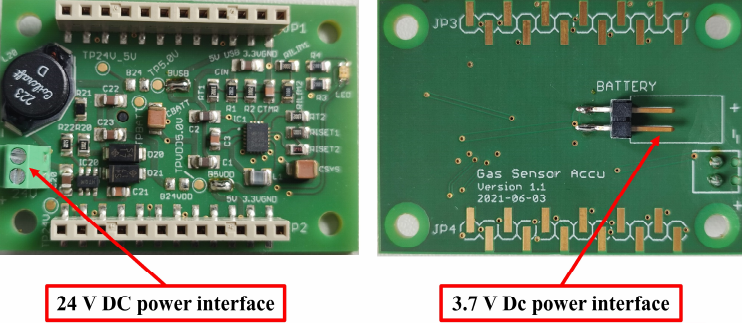
Figure 4. Power layer (front and back views).